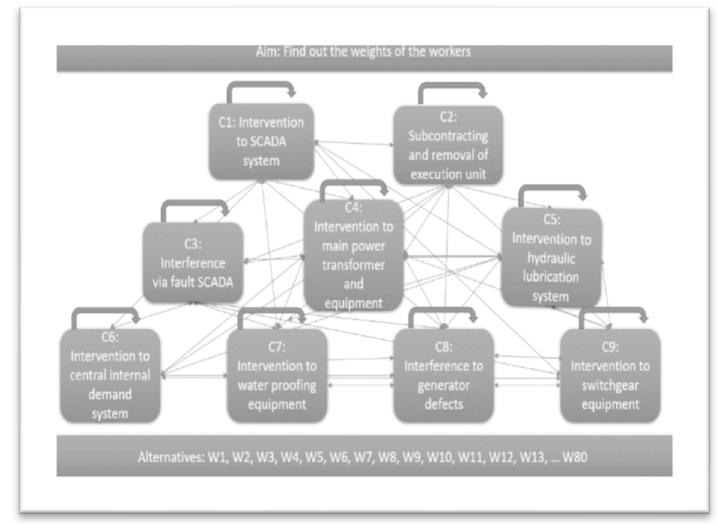
Figure 5. Schematic representation of the network structure